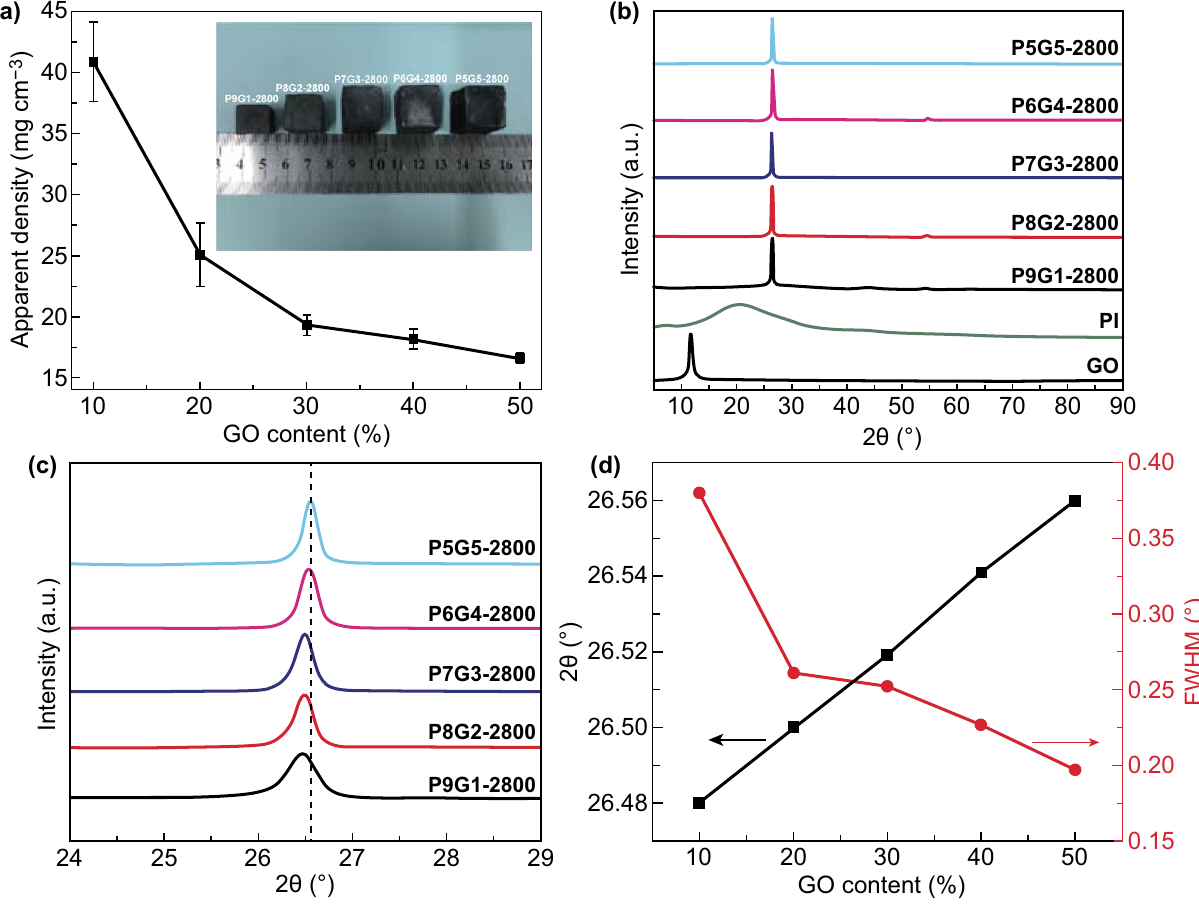
Fig. 2 a Plots of apparent density of LSGAs versus GO content in PAAS/GO suspensions; the inset shows the different sizes of LSGAs after the graphitization treatment. b, c XRD patterns of GO, PI, and LSGAs. d Plots of (002) diffraction angle and FWHM of LSGAs as a function of GO content in PAAS/GO